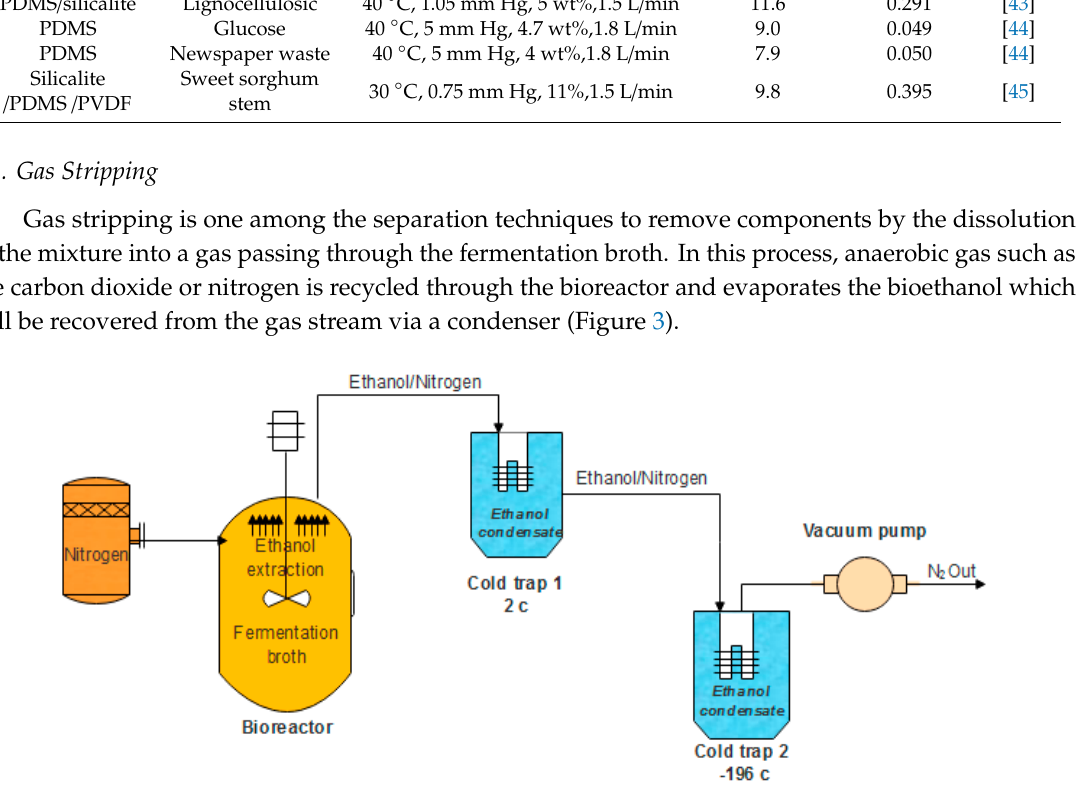
Figure 3. Schematic of integrated into situ extraction-gas stripping process.